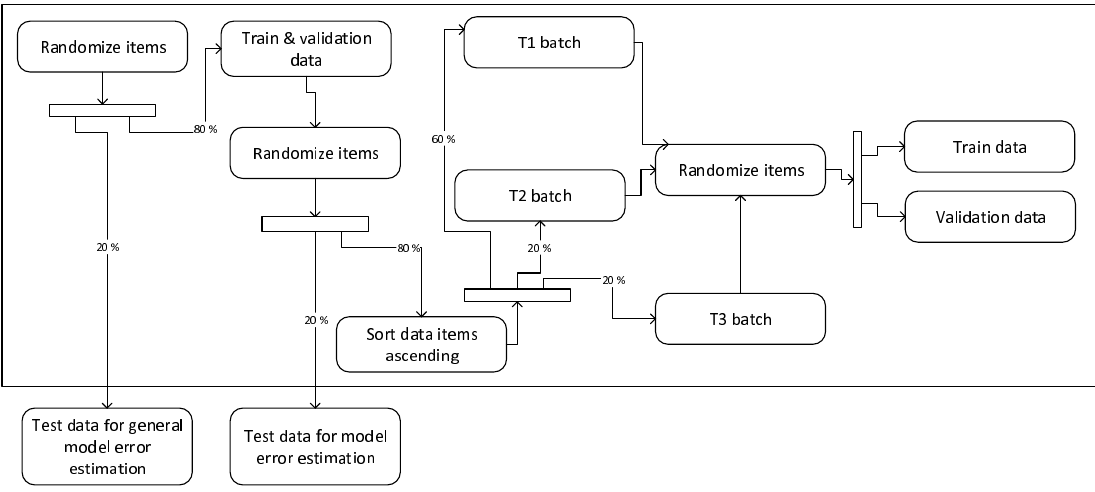
Figure 1. Data split